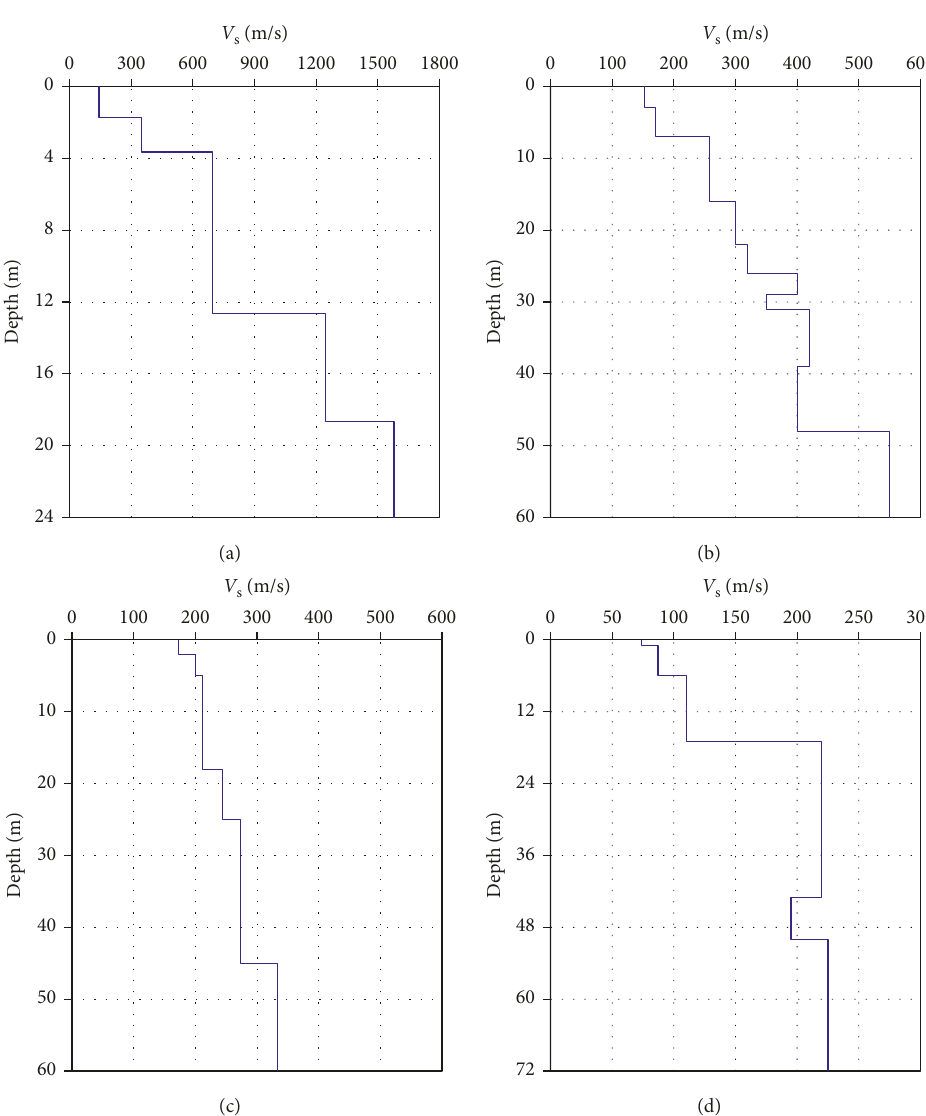
Figure 4: Shear velocity. (a) Site I. (b) Site II. (c) Site III. (d) Site